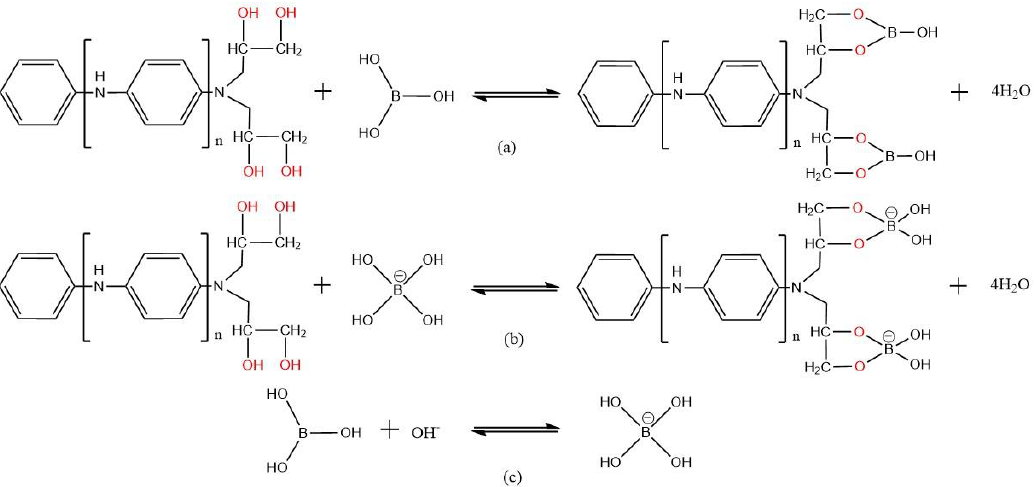
Figure 7. The possible adsorption mechanism for the as-prepared PANI-OH-3 adsorbents. (a) Complexation reaction between adsorbent and B(OH) 3 ; (b) Complexation reaction between adsorbent and [B(OH)4 − ]; (c) Hydrolysis of B(OH) 3 to [B(OH)4 − ].